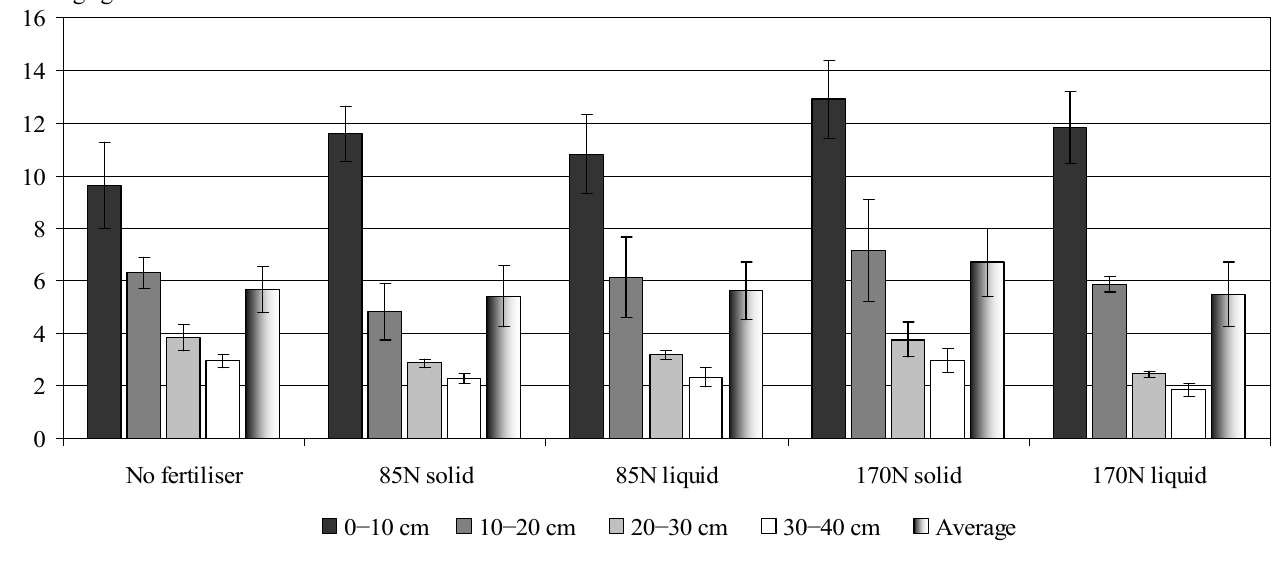
Figure 6. SOC content in grassland in Retisol, 2019.